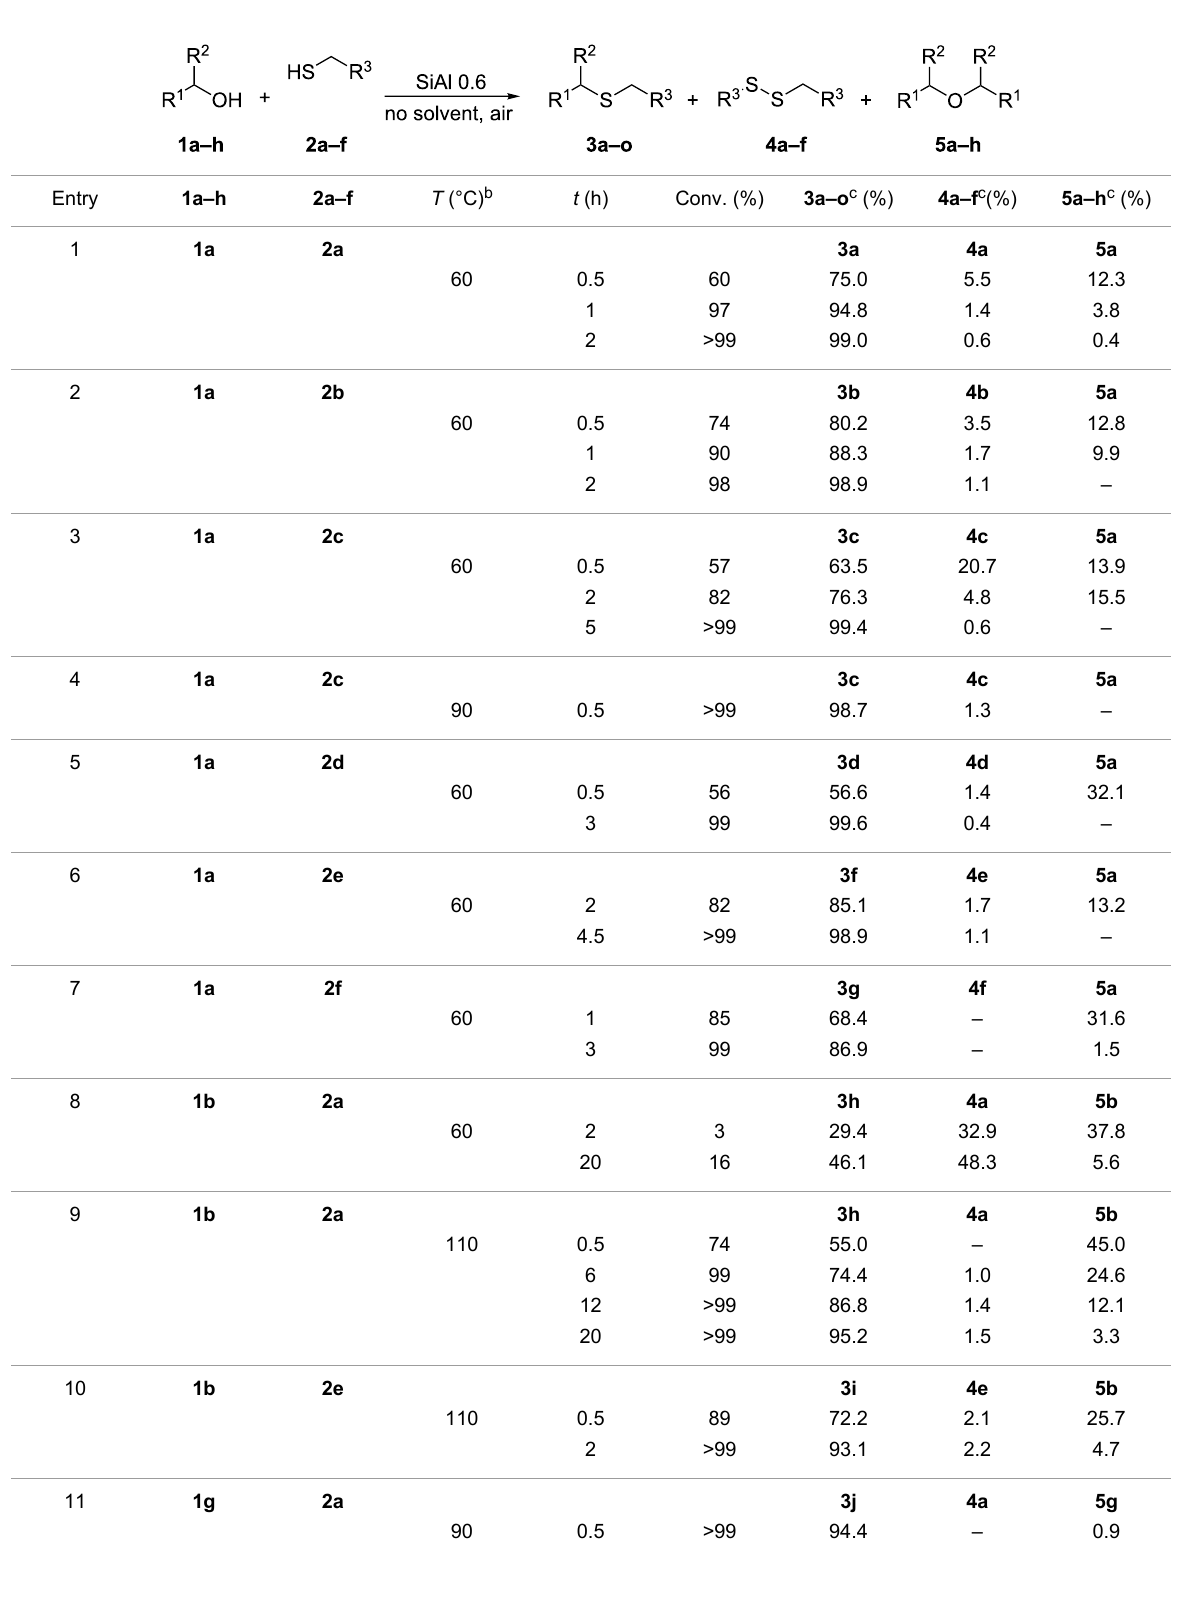
Table 2: Synthesis of thioethers from different alcohols and thiols promoted by SiAl 0.6 without solvent a